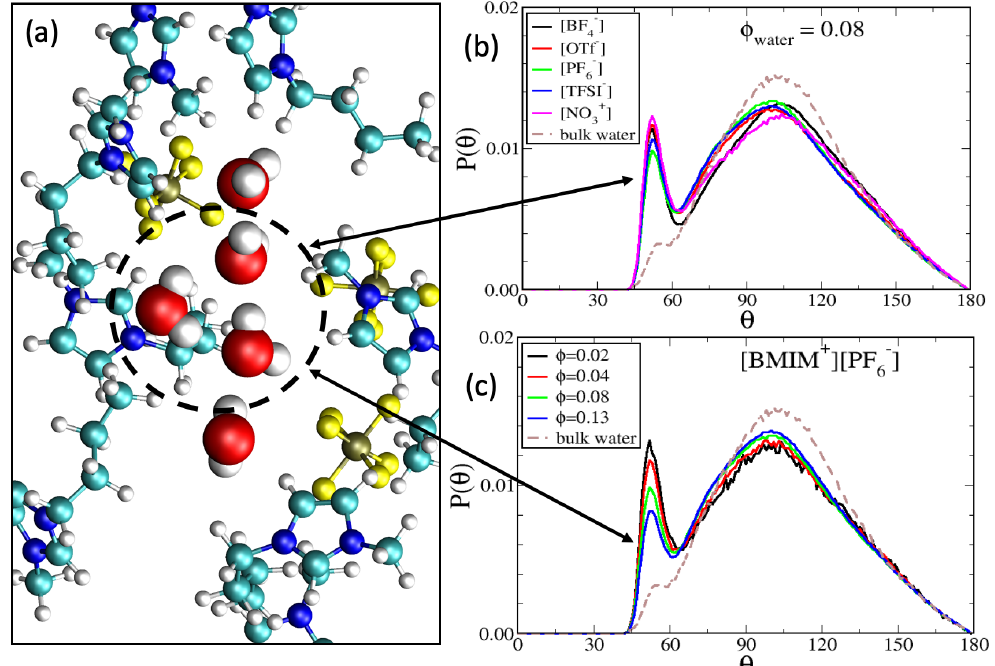
Figure 4. ( a ) Simulation snapshot of water triangle motif formed within [BMIM + ][PF − at φ water = 0.08 water content. Probability distribution of O-O-O angles for water trimers within ( b ) IL/water mixtures at φ water = 0.08 water content and ( c ) [BMIM + ][PF − varying water content. The distribution for bulk water was computed from a bulk water simulation with details analogous to those described in